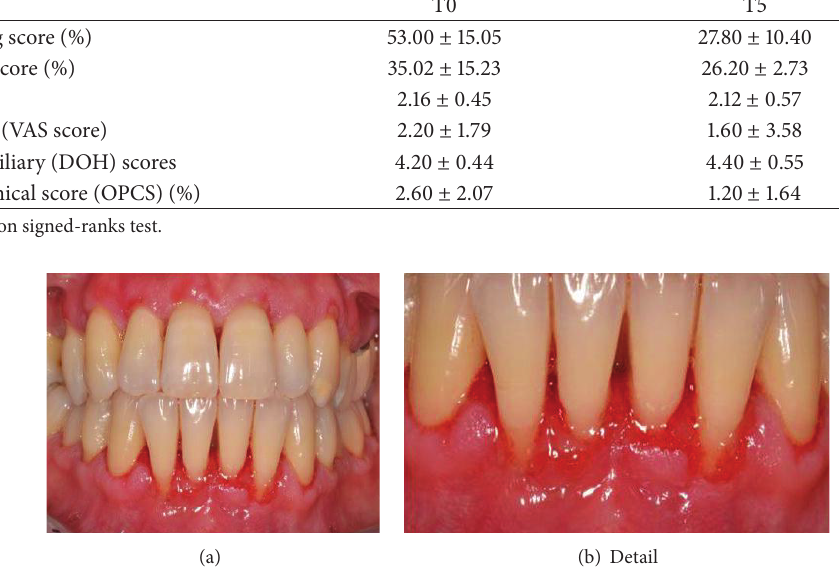
Figure 1: Clinical picture of the inferior frontal areas before periodontal treatment.